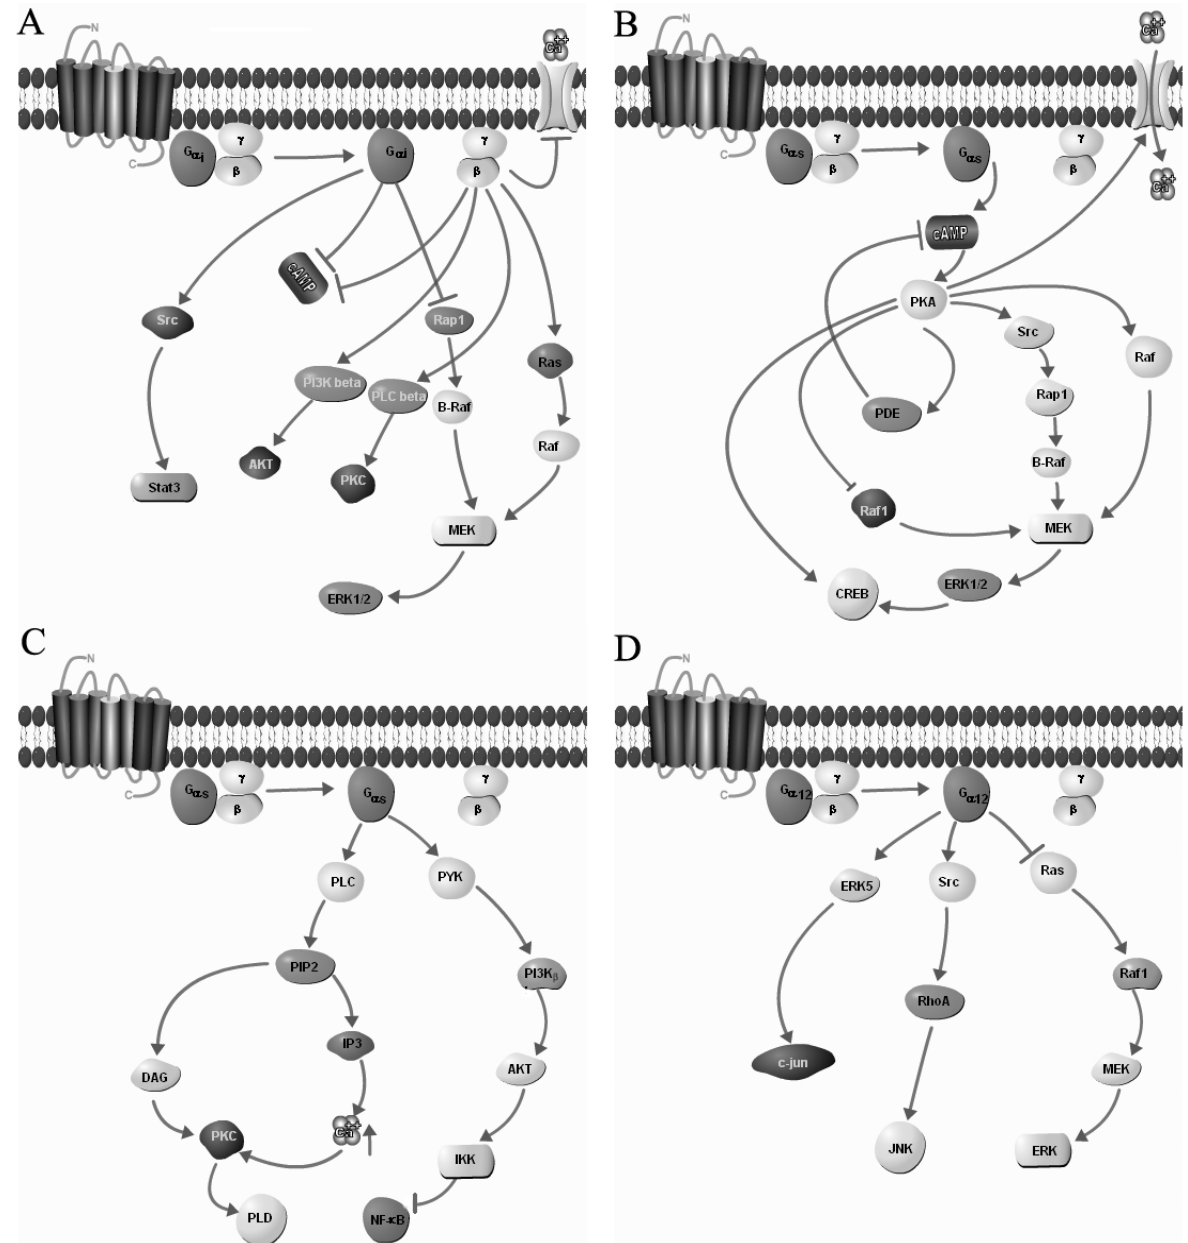
Figure 1. Schematic presentation depicting the regulation of receptor signaling through G-proteins. GPCRs upon activation couples to G regulates signaling in specific manner. Downstream signaling involving G depicted in panel A [78,79,81]. Figure was made by using the online pathway builder from Protein Lounge